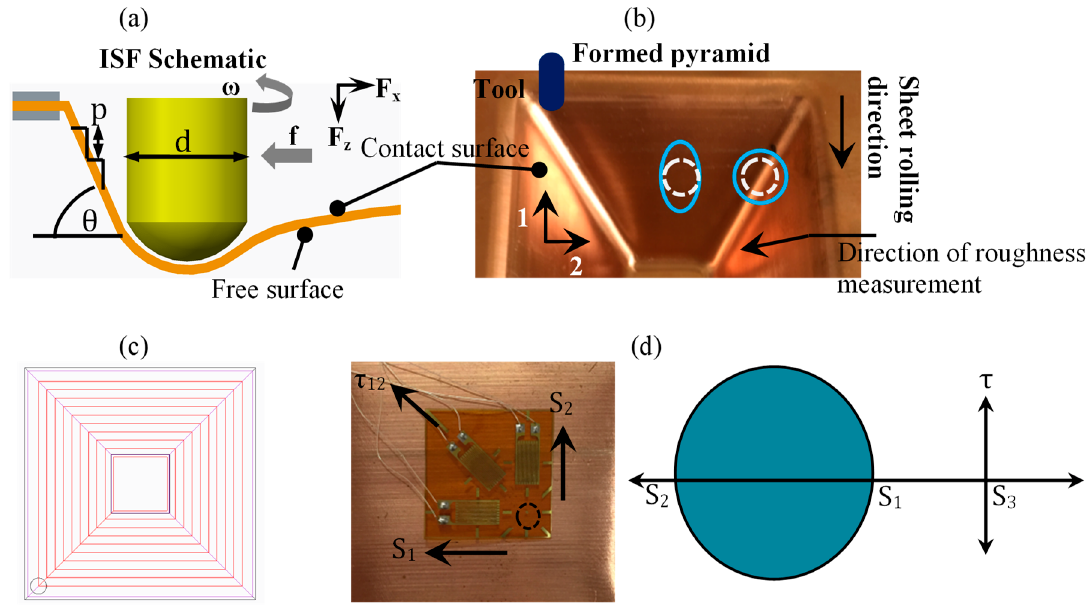
Figure 2. Forming and stress measurement: ( a ) ISF Schematic, ( b ) a formed geometry with the state of strain, ( c ) the tool path, and ( d ) the measurement of residual stress along with the state of residual stress. Table 1. The experimental plan and results.